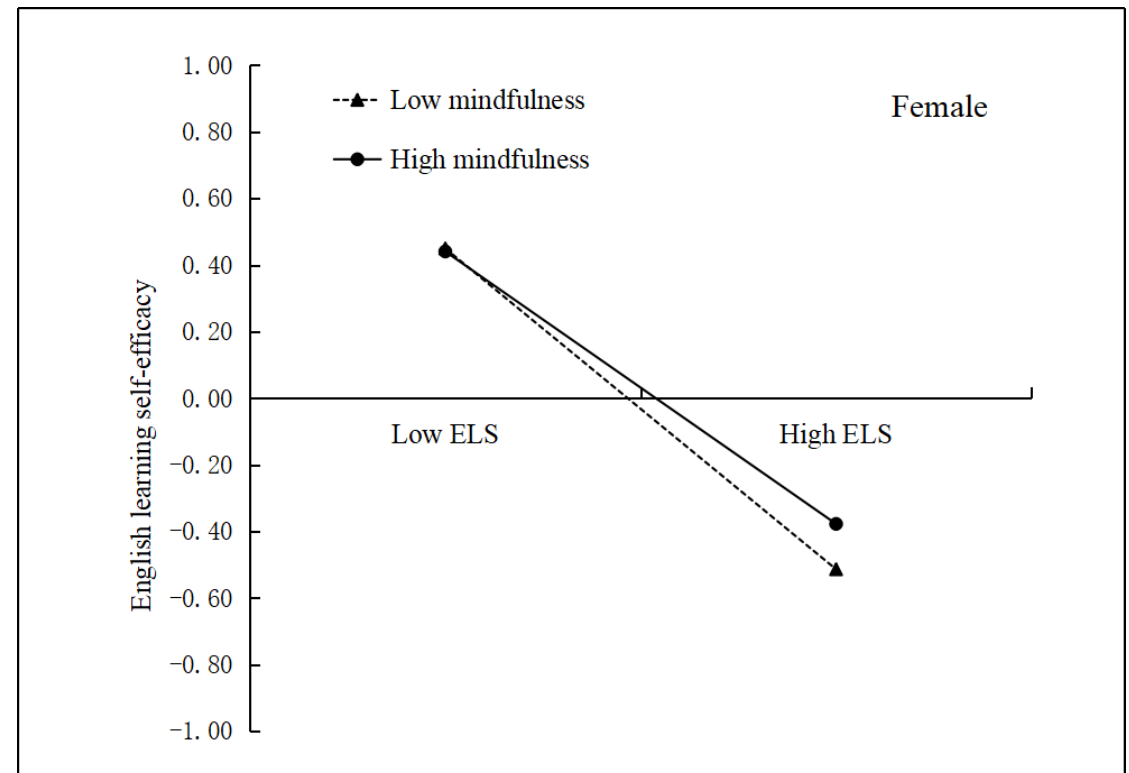
Figure 1. English learning self-efficacy as a function of English learning stress and mindfulness among male undergraduate students. ELS = English learning stress.